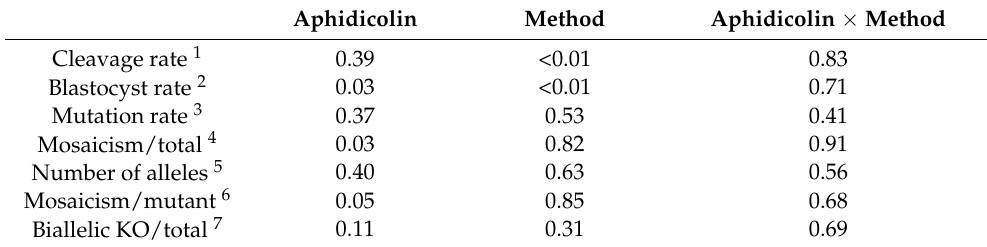
Table 3. Two-way ANOVA of effect of aphidicolin and methodology (Method).